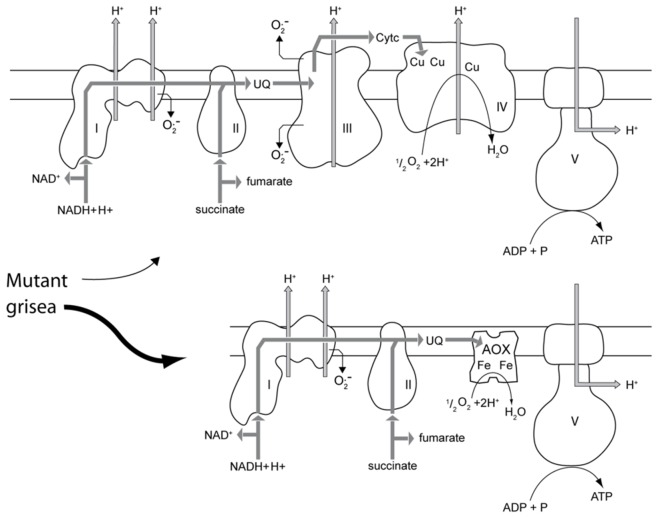
Copper-dependent standard and alternative respiration in P. anserina.While respiration of the wild type predominantly proceeds via the standard copper-dependent pathway, respiration in the grisea mutants does mainly follow the alternative route utilizing the di-iron containing alternative oxidase.